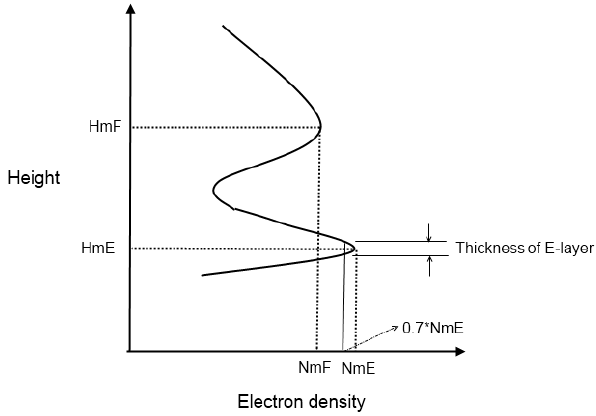
Figure 2. An illustration of some characteristics parameters during the presence of ELDI. See text for